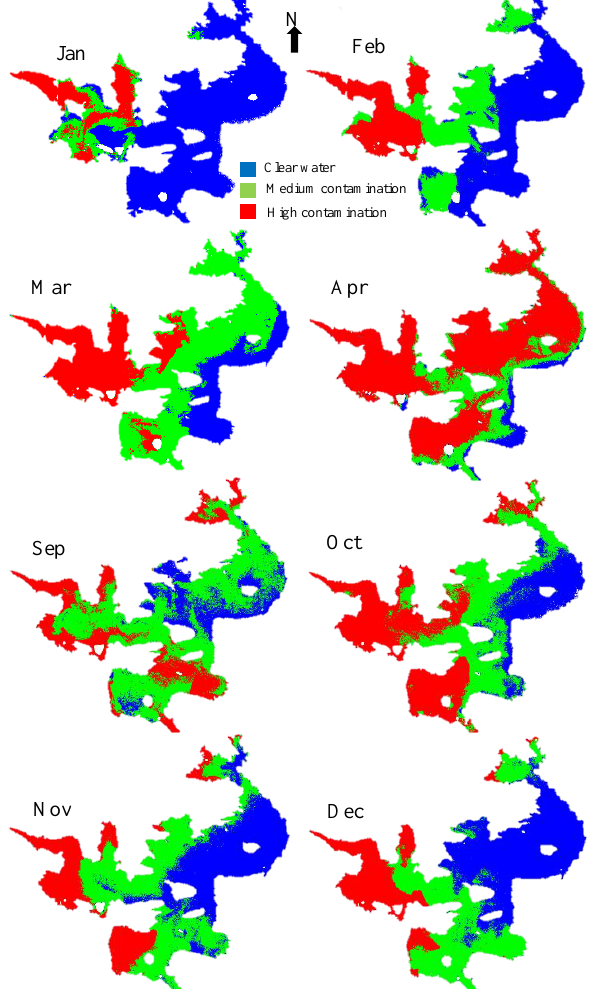
Figure 3. Classification results showing the spread of contaminations in NS from Jan to Dec in